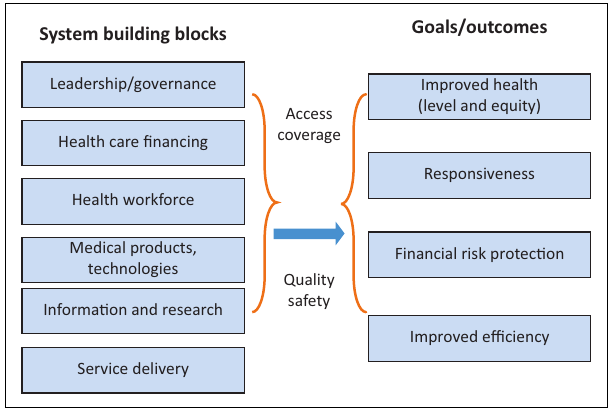
FIGURE 1: World Health Organization health system building blocks.